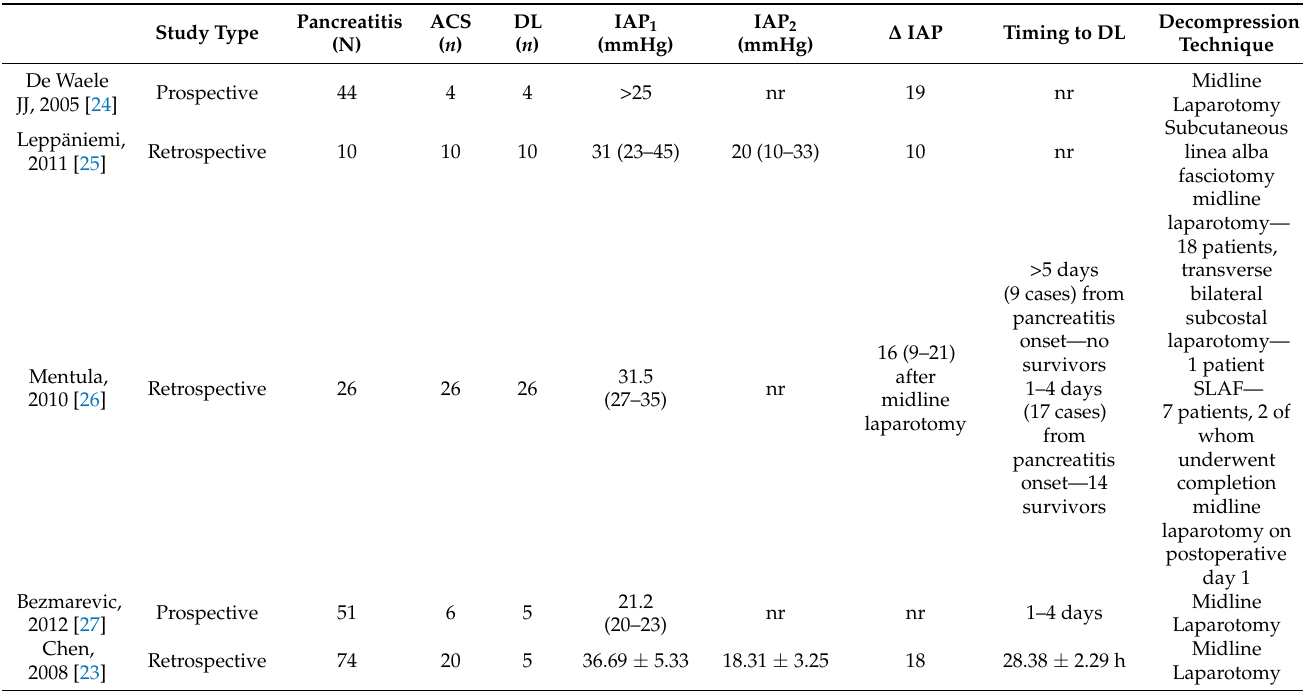
Table 1. Abdominal compartment syndrome in the context of acute pancreatitis in different studies. ACS—abdominal compartment syndrome; DL—decompression laparotomy; IAP—intra-abdominal pressure; IAP1—intra-abdominal pressure before decompression; IAP2—intra-abdominal pressure after decompression; ∆ IAP—decrease in IAP after decompression; nr—not reported; SLAF—subcutaneous linea alba